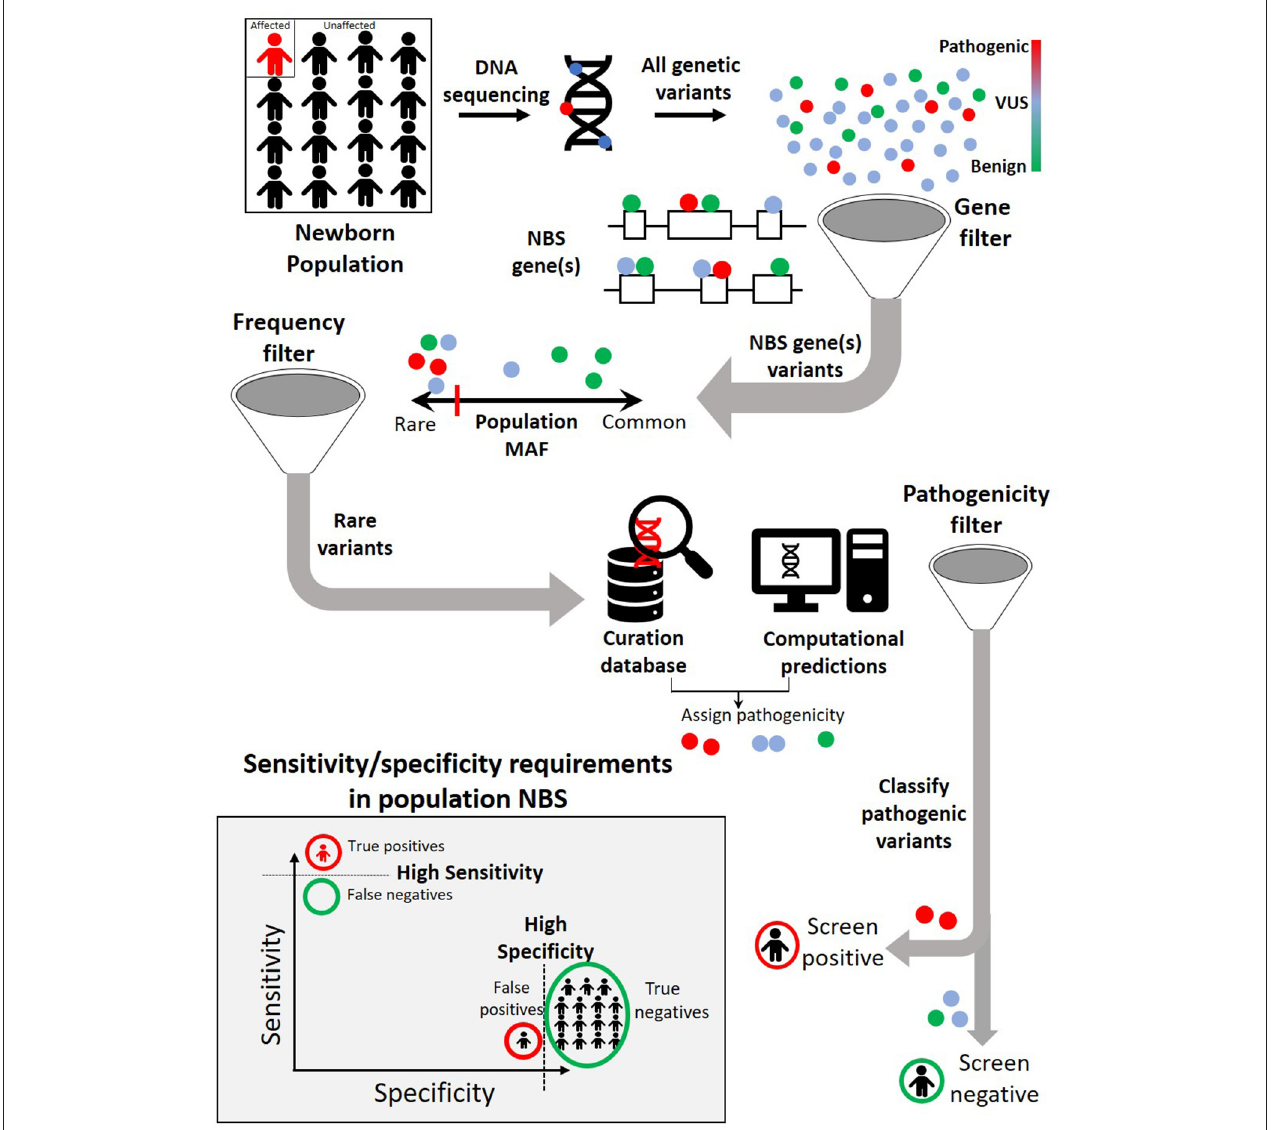
FIGURE 2 | A typical genomic analysis pipeline in the context of newborn screening (NBS). Among all the variants observed in the newborn DNA sequence, only those occurring in previously identified NBS genes are considered further. Within NBS genes, rare variants are prioritized over common variants. A combination of curated pathogenic variant databases and computational prediction tools is utilized to assign variant pathogenicity and screen for individuals who carry such variants. For NBS, the pipeline will need to demonstrate both a high sensitivity (screen positive almost all newborns with disease) and a high specificity (screen negative almost all newborns without